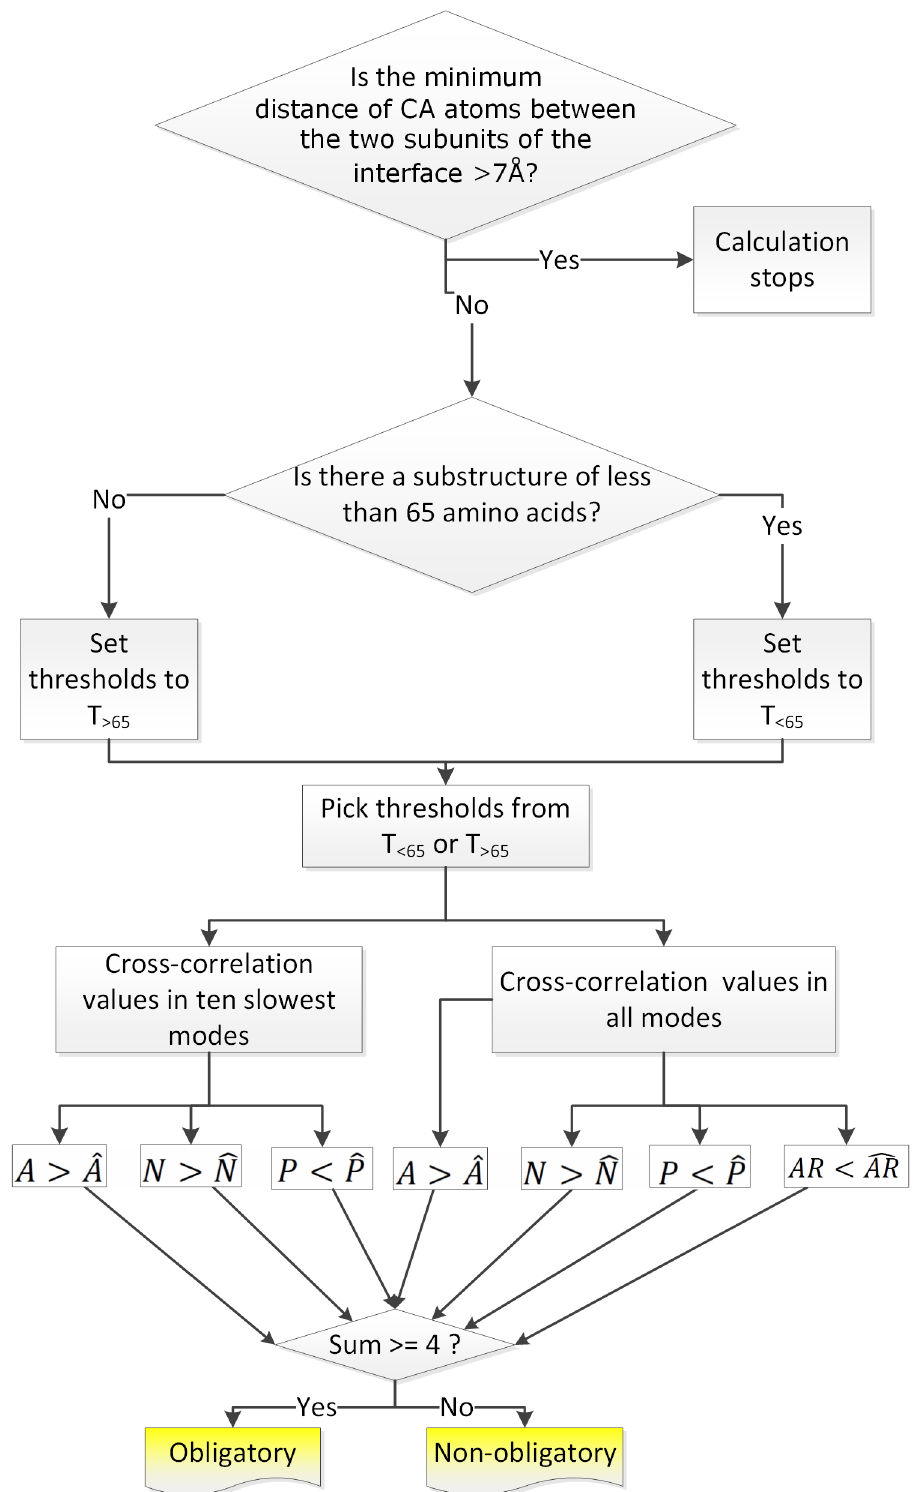
Fig 1. Flowchart of the DynaFace web server. A is the average of all cross-correlation values between different subunits, N is the average of negative cross-correlation values between different subunits, P is